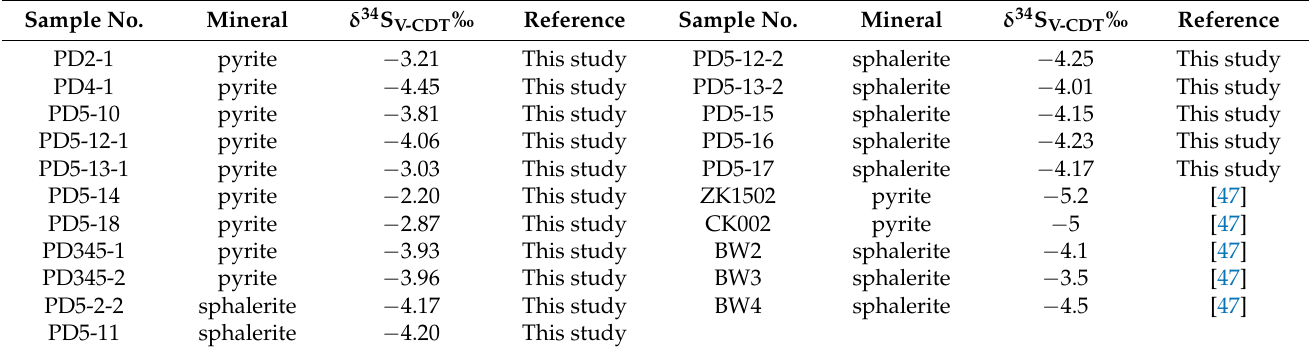
Table 3. Sulfur isotopic compositions of the Bawang deposit (‰).